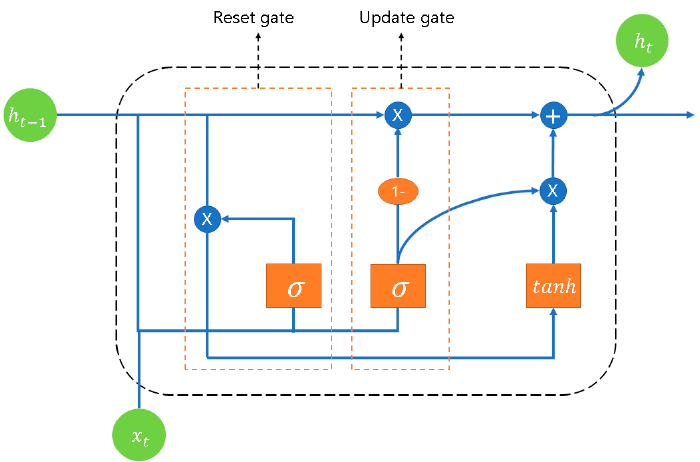
Figure 3. Gated recurrent unit network